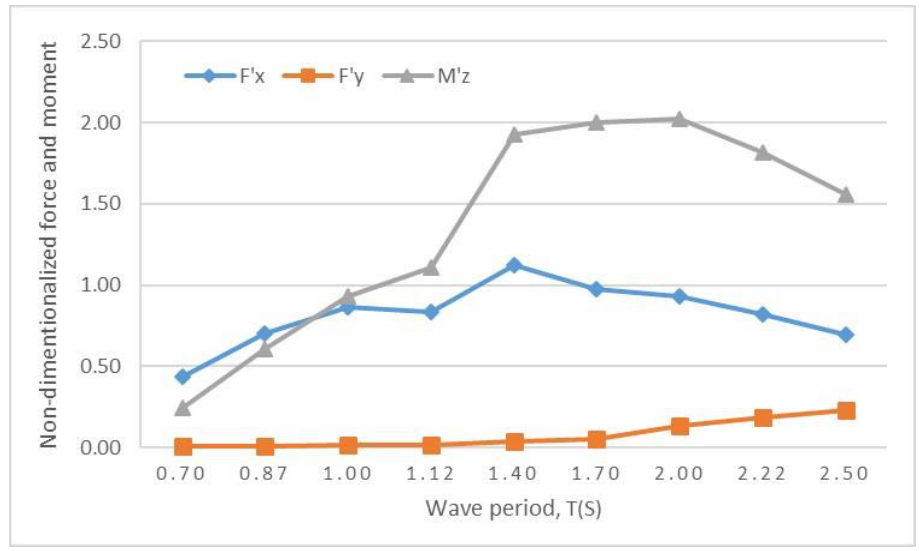
Figure 10. Non-dimensional horizontal force F x , vertical force F y , and pitch moment M z acting on the truncated cylinder at different wave periods.